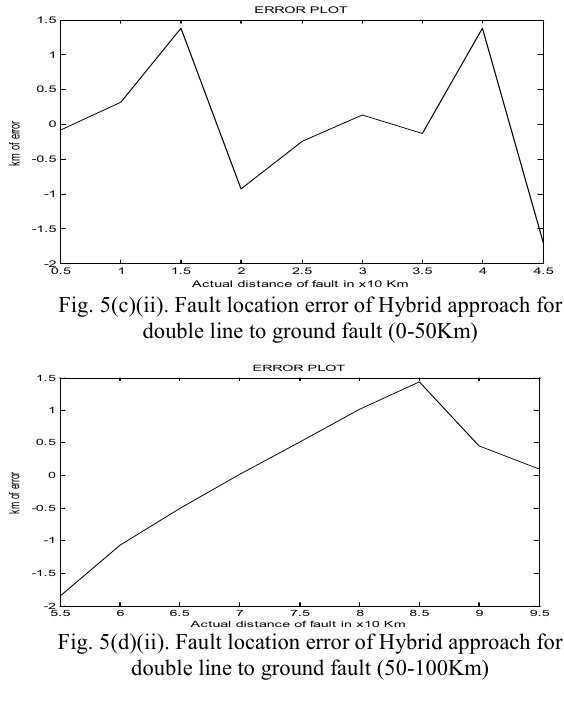
Fig. 5(d)(ii). Fault location error of Hybrid approach for double line to ground fault (50-100Km)